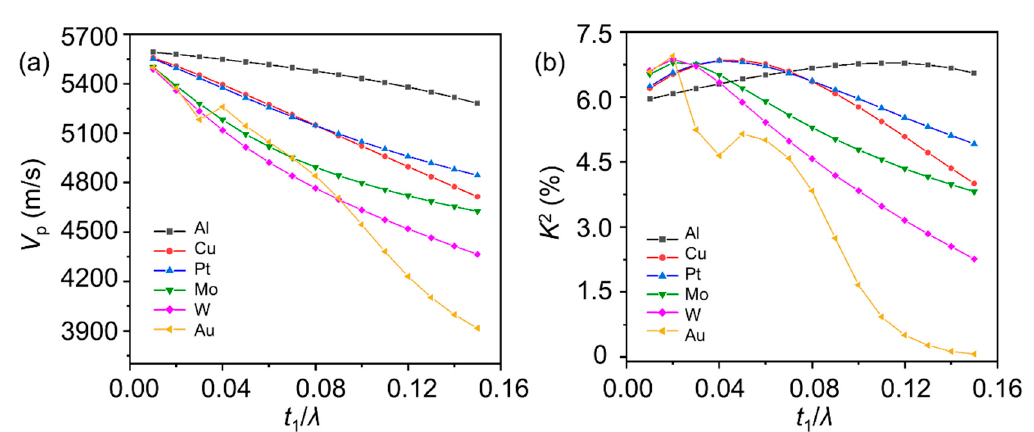
Figure 5. V p ( a ) and K 2 ( b ) of quasi-Sezawa wave as functions of top electrode thickness t 1 / λ based on the partially etched ZnO/SiC structure when the etching ratio d / h = 0.7 and ZnO thickness h / λ = 0.6.